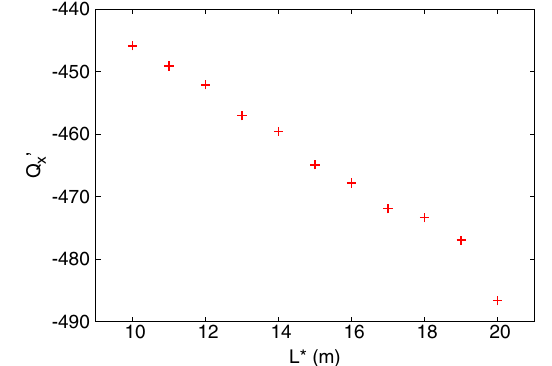
FIG. 7. Natural chromaticity plotted as a function of L (cid:1) with β (cid:1) fixed at 10